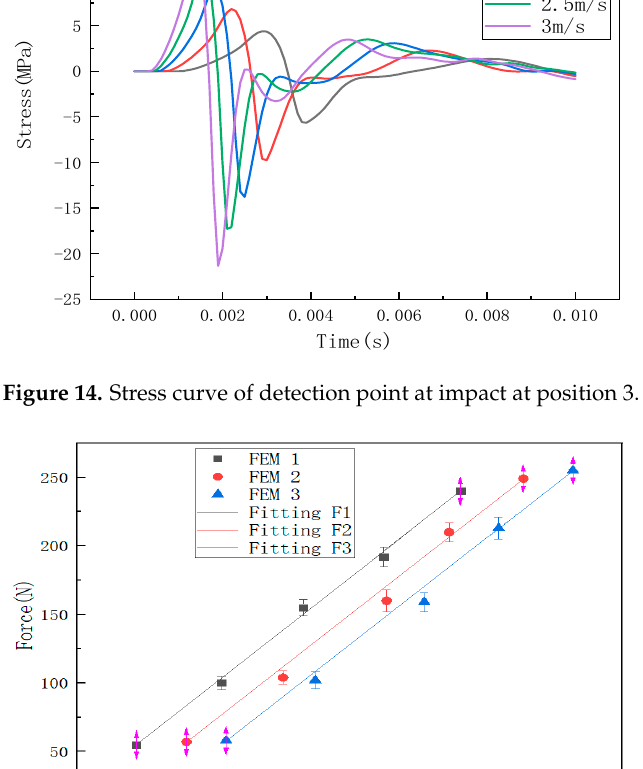
Figure 14. Stress curve of detection point at impact at position 3.